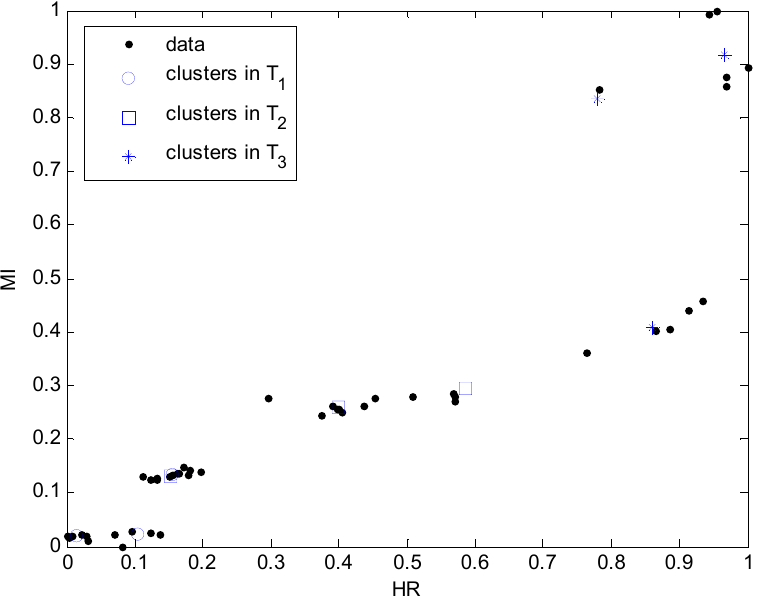
Figure 10. Data distribution and cluster centers estimated in each